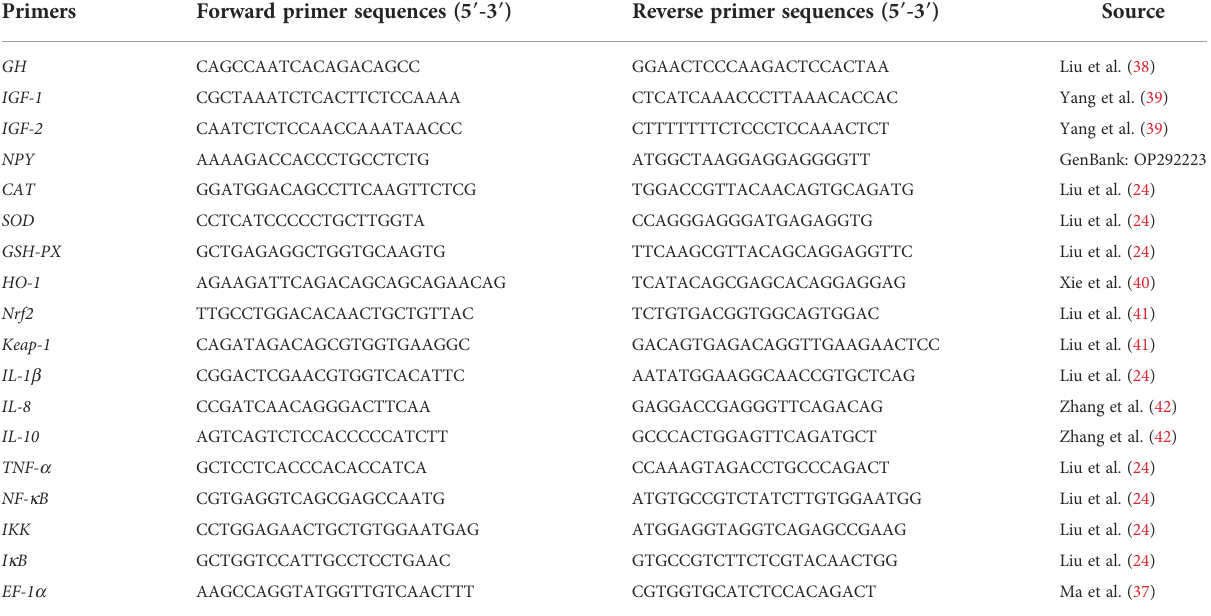
TABLE 3 Real-time PCR primer